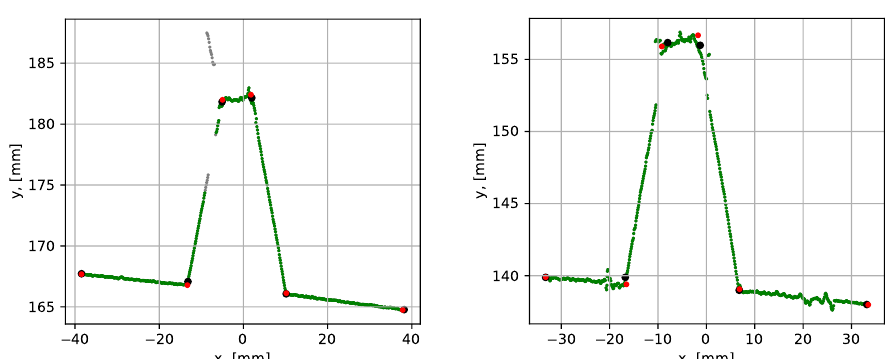
Figure 26. Parametrization results with groove corner points for datasets 14 (to the left) and 15 (to the right). The red dots show the result from the proposed procedure and the black dots show results from the conventional RANSAC. The grey points have been identified as noise by the noise detection